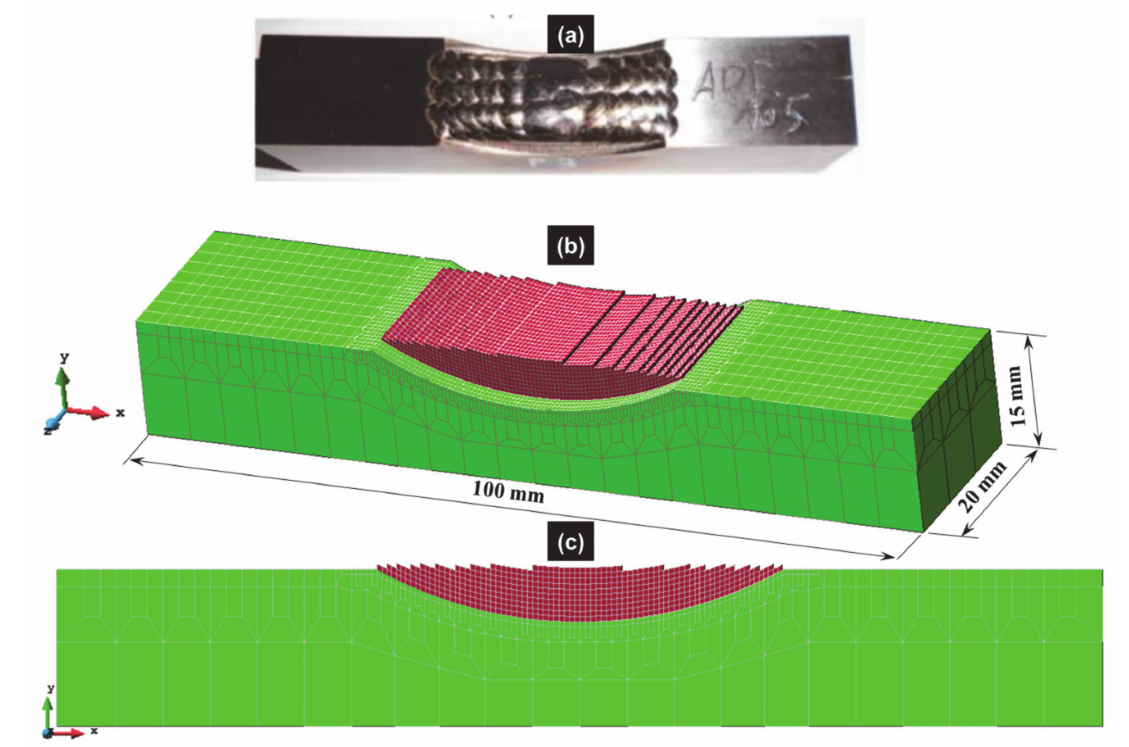
Figure 7. ( a ) Deposit in the as-built conditions, and 3D finite element mesh used for the numerical simulation of the laser cladding process; ( b ) 3D view; ( c ) front